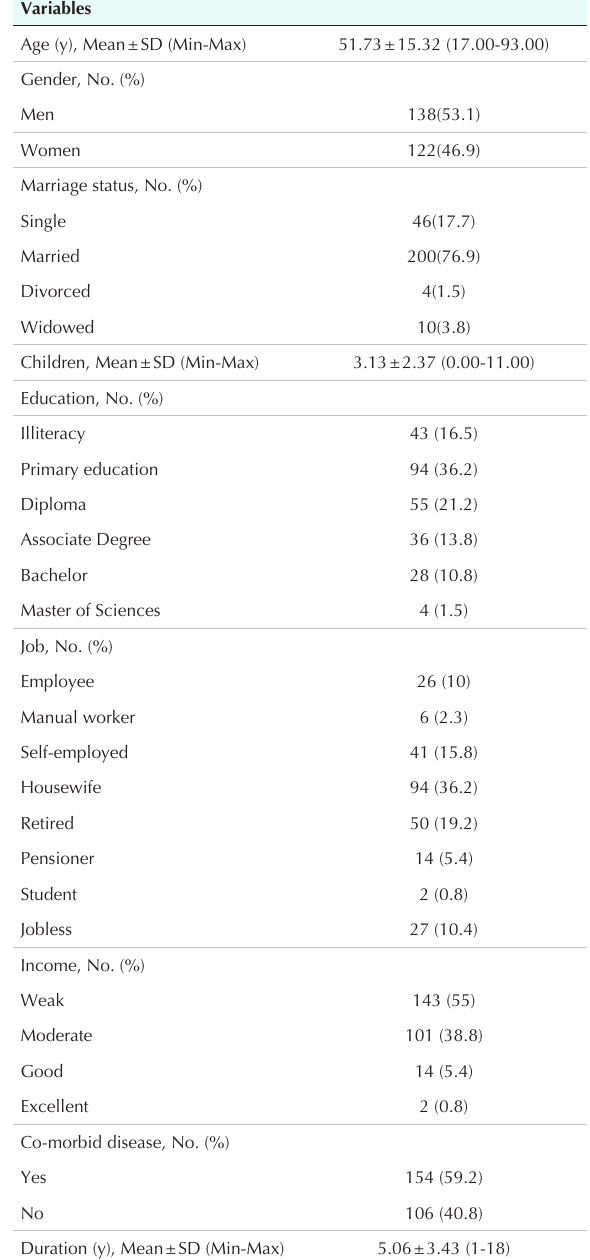
Table 1 . Sociodemographic characteristics of HD patients (n = 260)